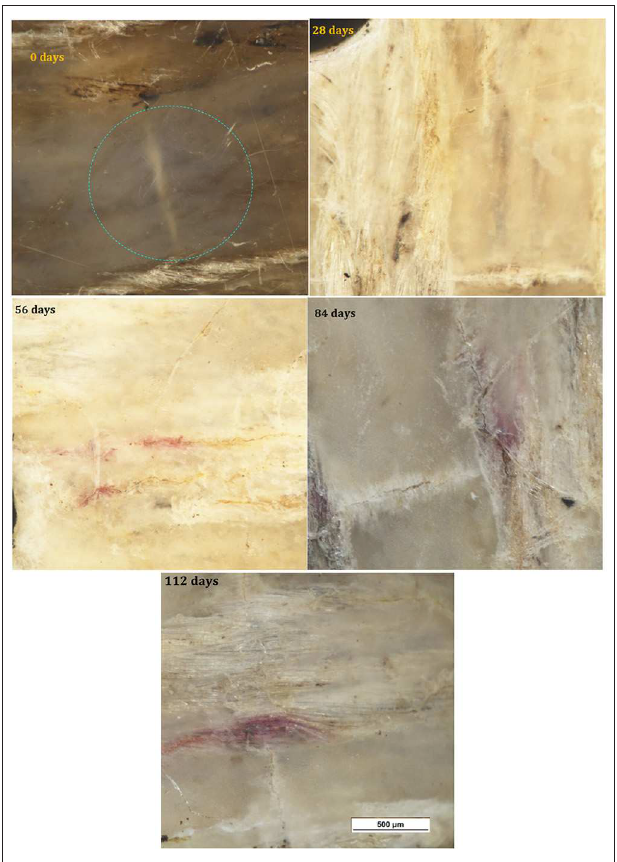
FIGURE 6 | Optical micrographs of PHBV/flax at 0, 28, 84, and 112